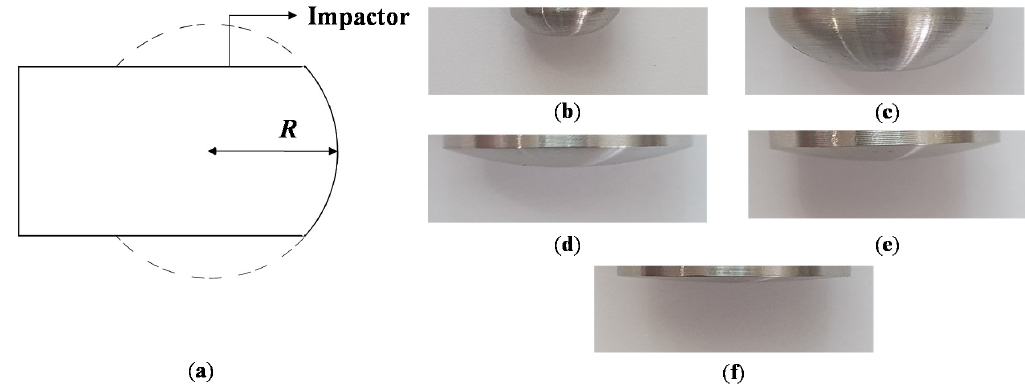
Figure 1. Images of damages in the specimens induced by di ff erent impactor shapes: ( a ) a barely visible impact damage induced by a blunt impactor (impactor with R = 4 mm, 12 J impact energy) and ( b ) a visible impact damage induced by sharp impactor (conical impactor, 12 J impact energy).